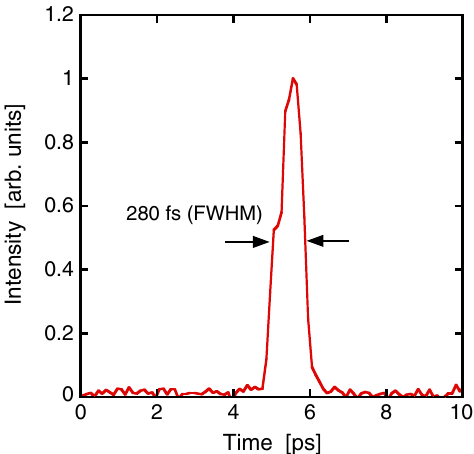
FIG. 27. HEM - 11 - ð 5 = 6 Þ (cid:5) -mode backward-traveling-wave ac- celerating structure with racetrack-shape rf coupling irises to prevent X - and Y -mode